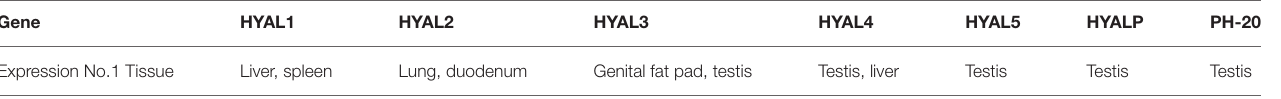
TABLE 1 | Overview of the expression pattern of the seven hyaluronidase genes found in the genome of Mus musculus .